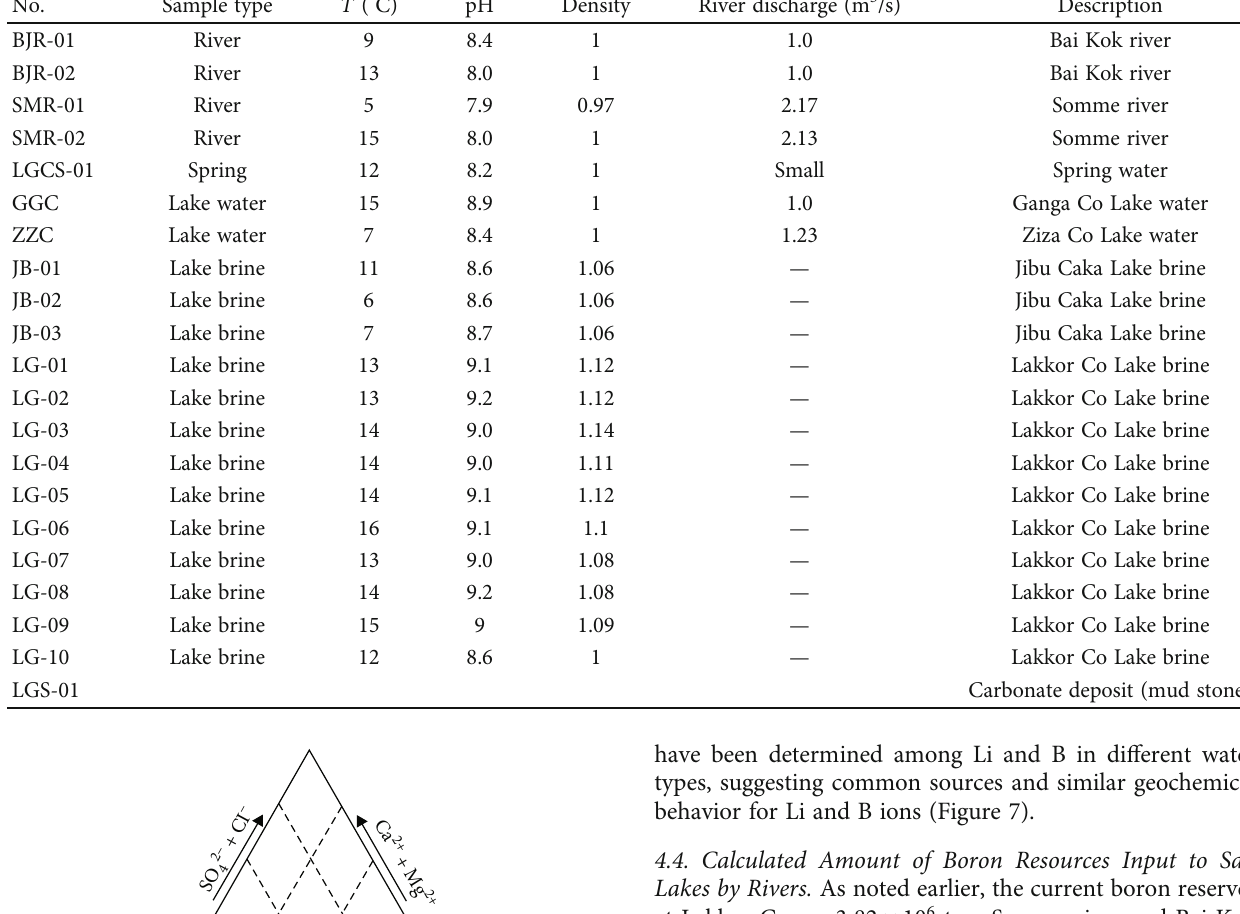
Table 2: Water chemical data of the rivers, spring, lake brine, and solid boron ore in Lakkor Co area. No.